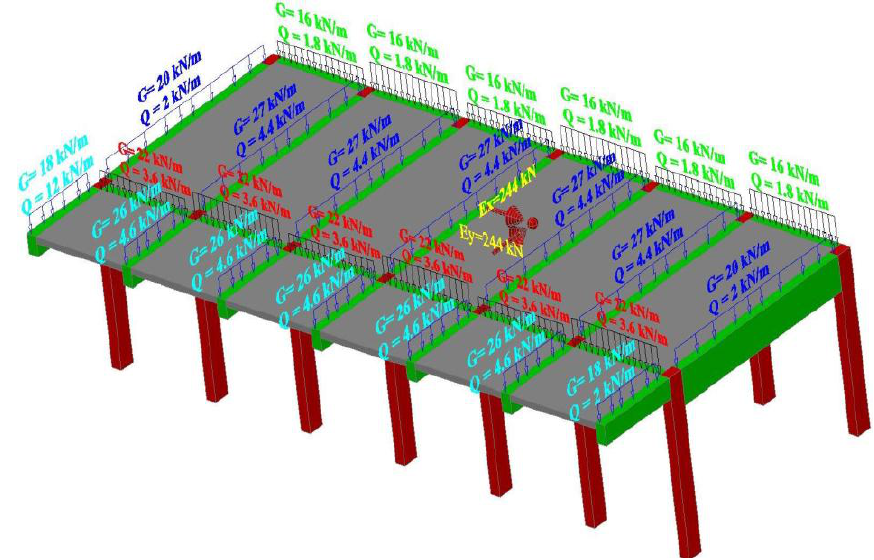
Fig. 7 . Used vertical and earthquake loads in the analyses.